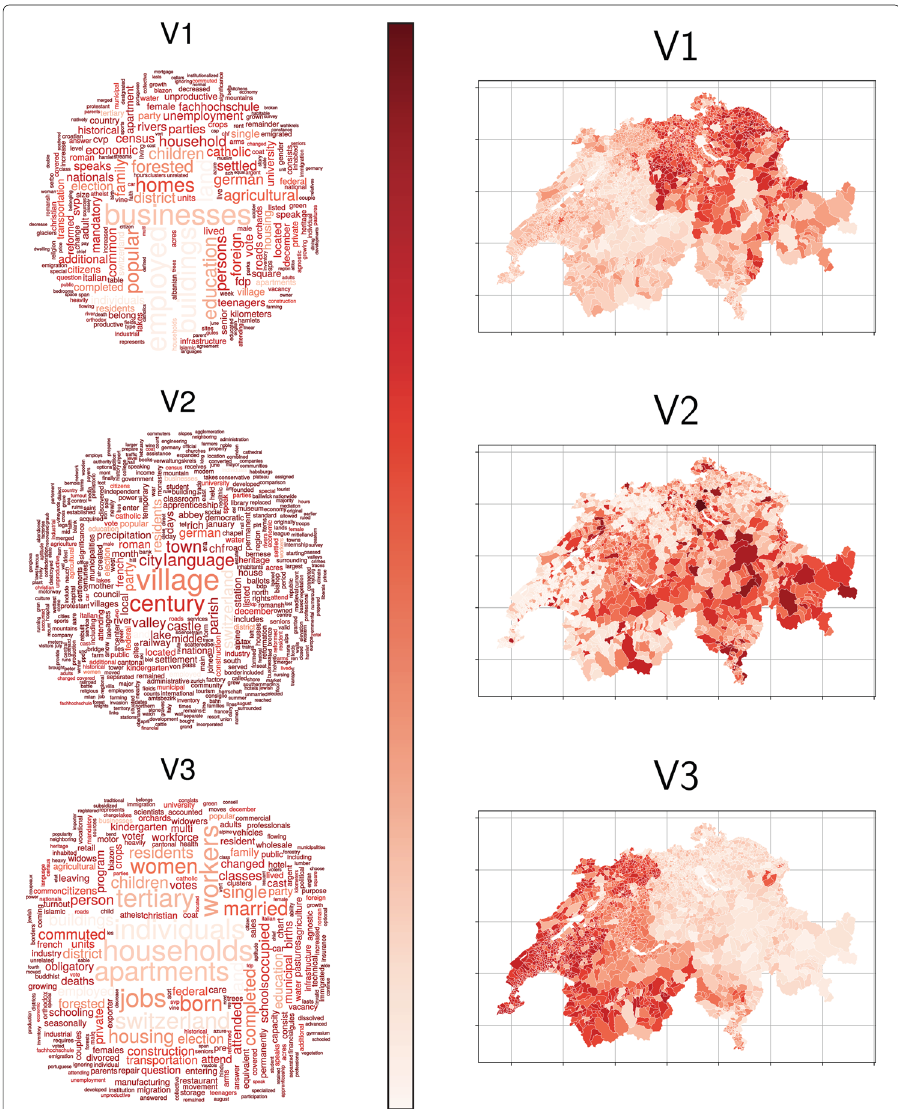
Fig. 2 For k = 3 topics, Left : topic wordclouds (Fellows 2014) obtained from the C matrix for topic model with parameters: burning = 4 (cid:6) 000, 2 (cid:6) 000 iteration, thin = 500, seeds = { 2 (cid:6) 003,5,63,100 (cid:6) 001,756 } , nstart = 5 and best = true. The colour scale is the inverse of the frequency of the word in the whole dataset (e.g. more specific words are darker than common words) whereas their size represents their importance in the topic. Right : related maps with the probabilities of the municipalities over each topic (Map base source: FSO)